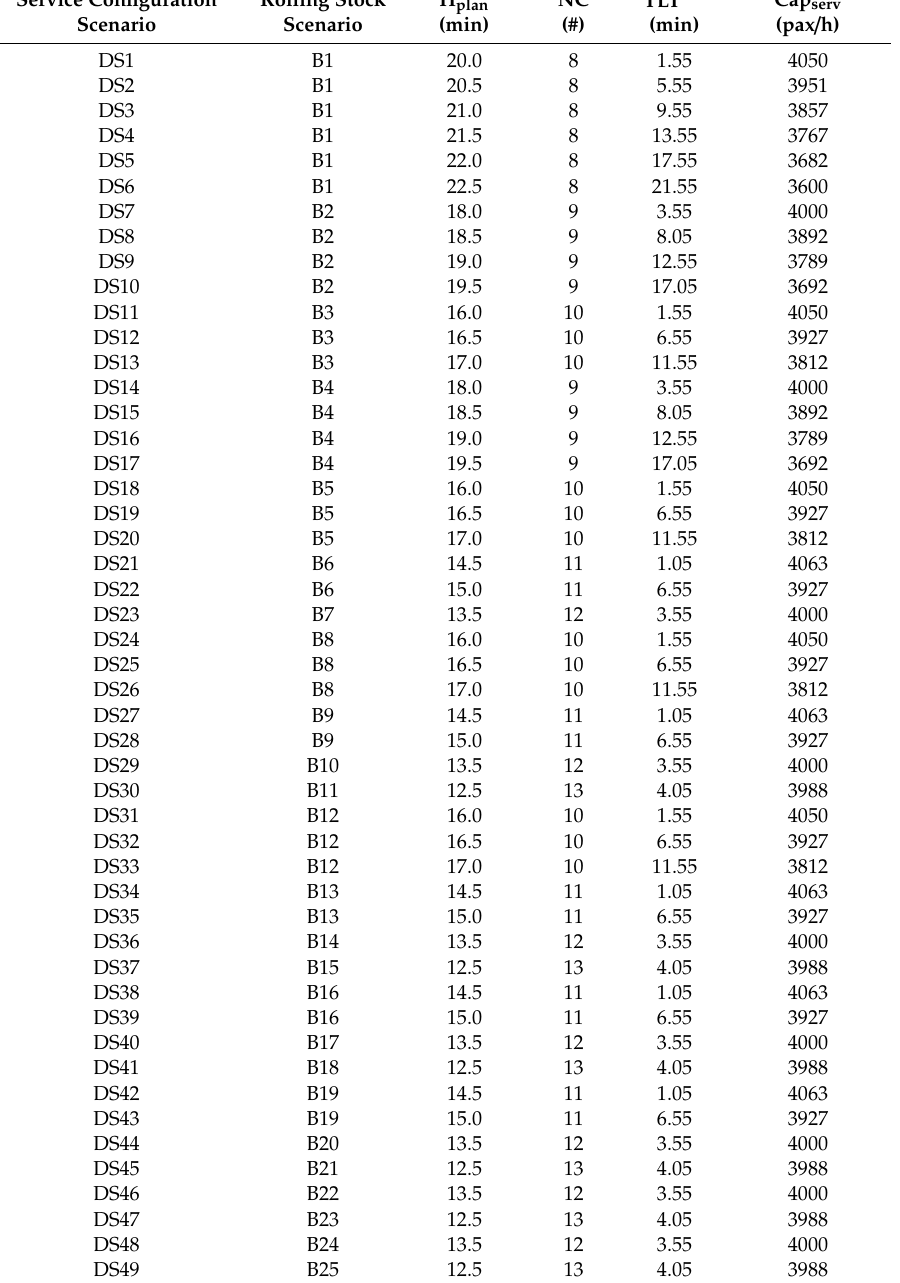
Table A2. Service configurations implementable in disrupted